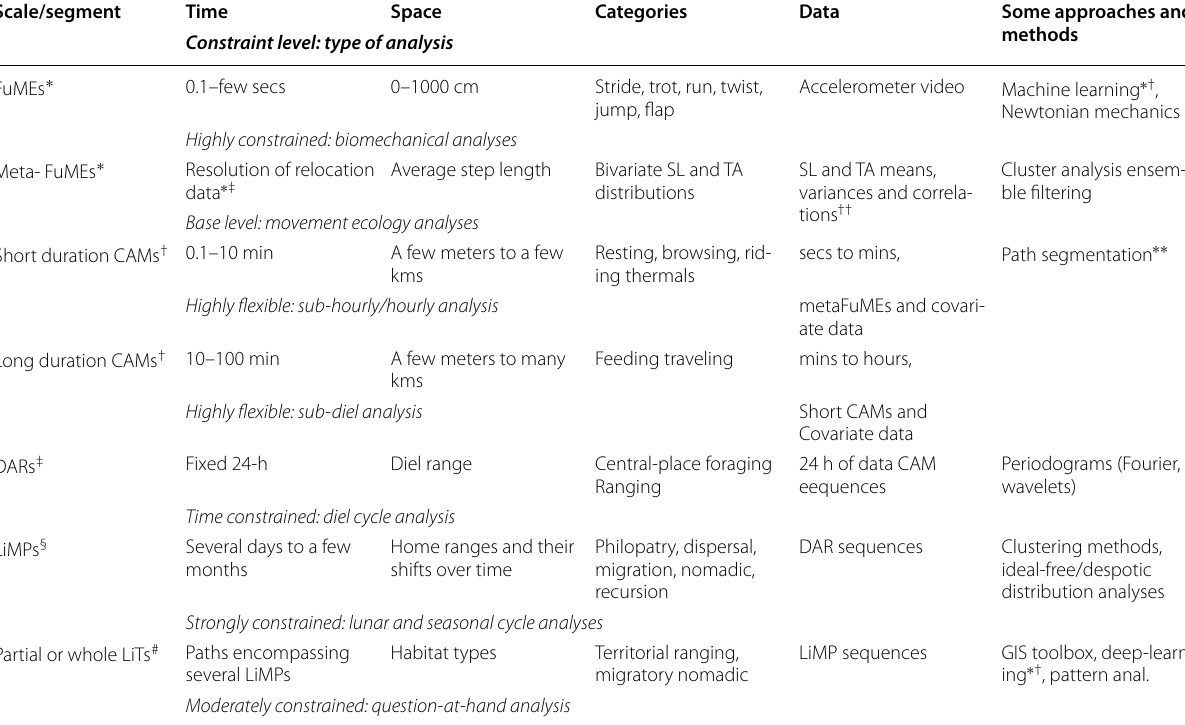
Table 1 Hierarchical organization of a typical vertebrate lifetime track